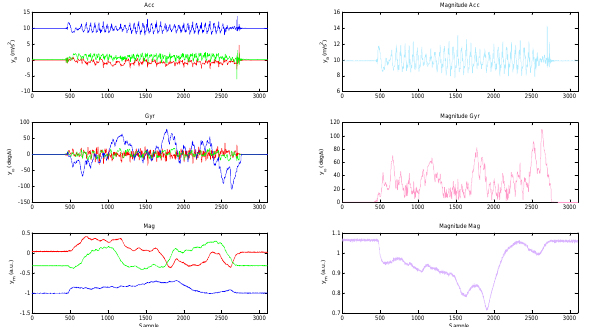
Figure 3: Input signal from the walking trial (with the IMU near the torso) that was used for in-use calibration. The red, green, and blue in the left column represents the x, y, and z components, respectively.